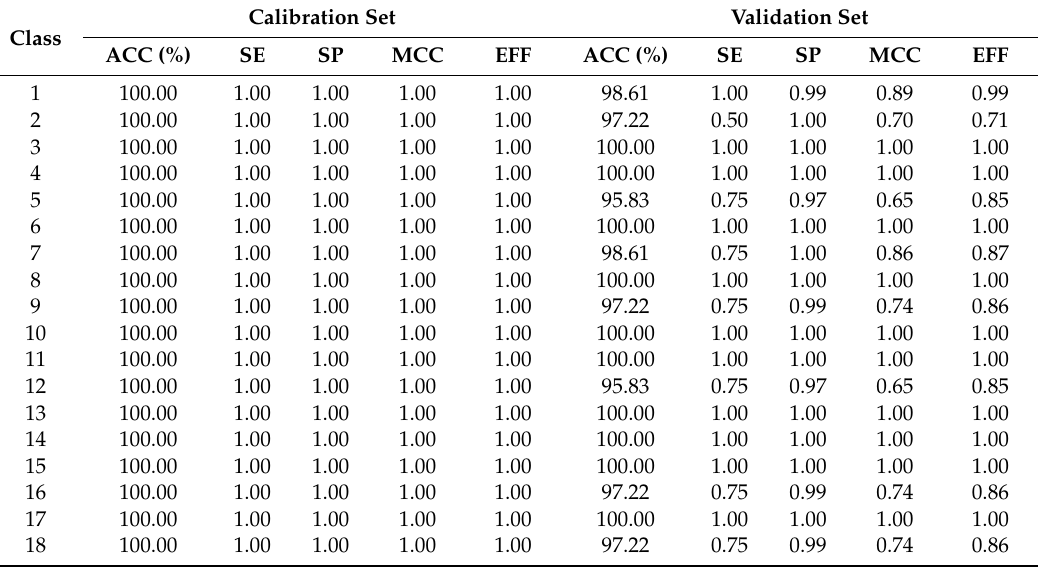
Table 5. The major parameters of K-nearest neighbors (KNN) model based on NIR full spectra data.